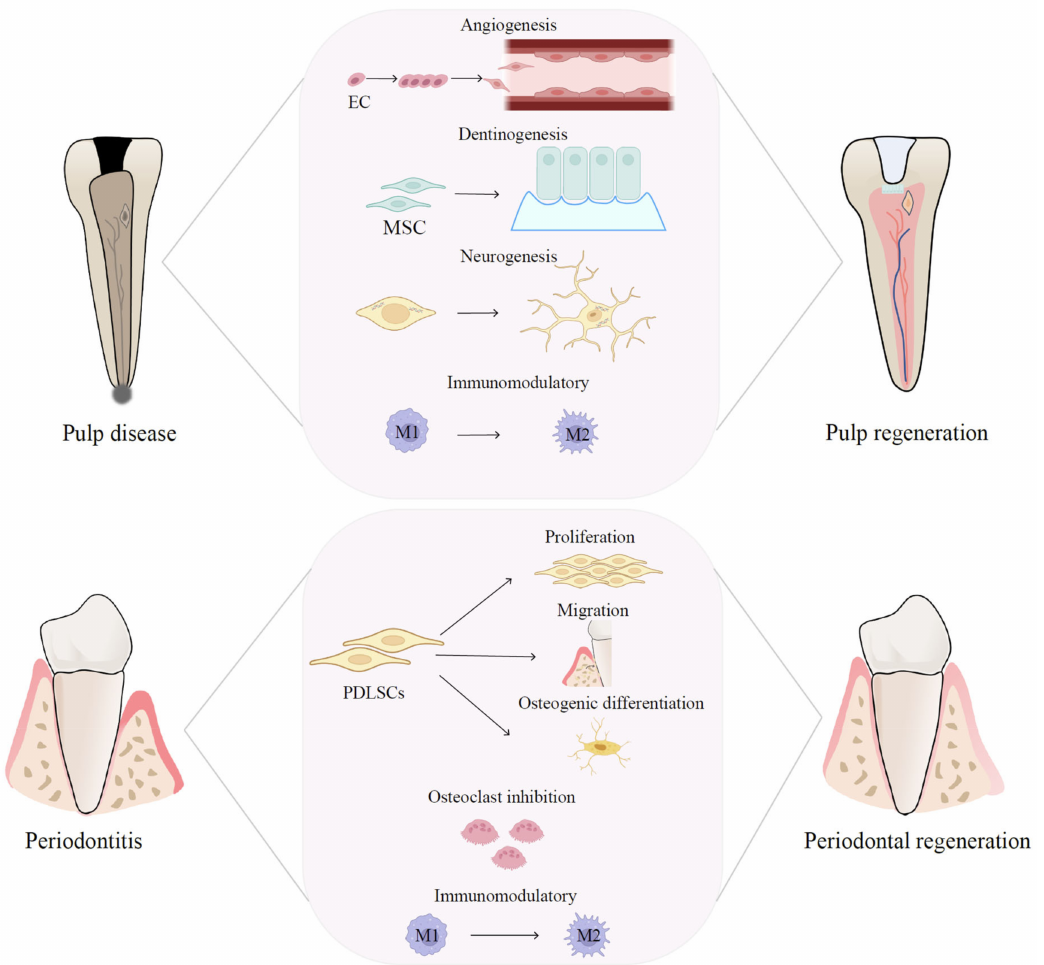
Figure 4. Therapeutic mechanisms of EVs in pulp and periodontal regeneration. EV-based therapies are promising therapeutic approaches for pulp and periodontal regeneration and have the potential to regulate the immune microenvironment, boost angiogenesis, facilitate neural regeneration, and promote MSC proliferation and